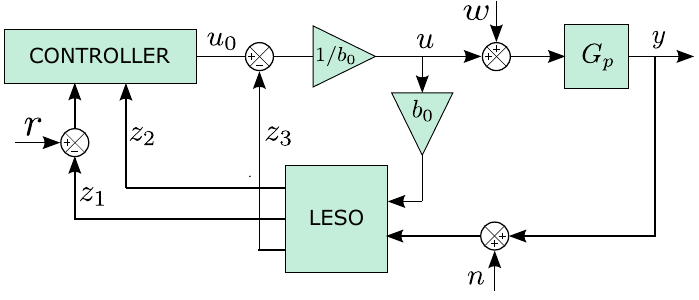
Figure 8. LADRC block diagram.